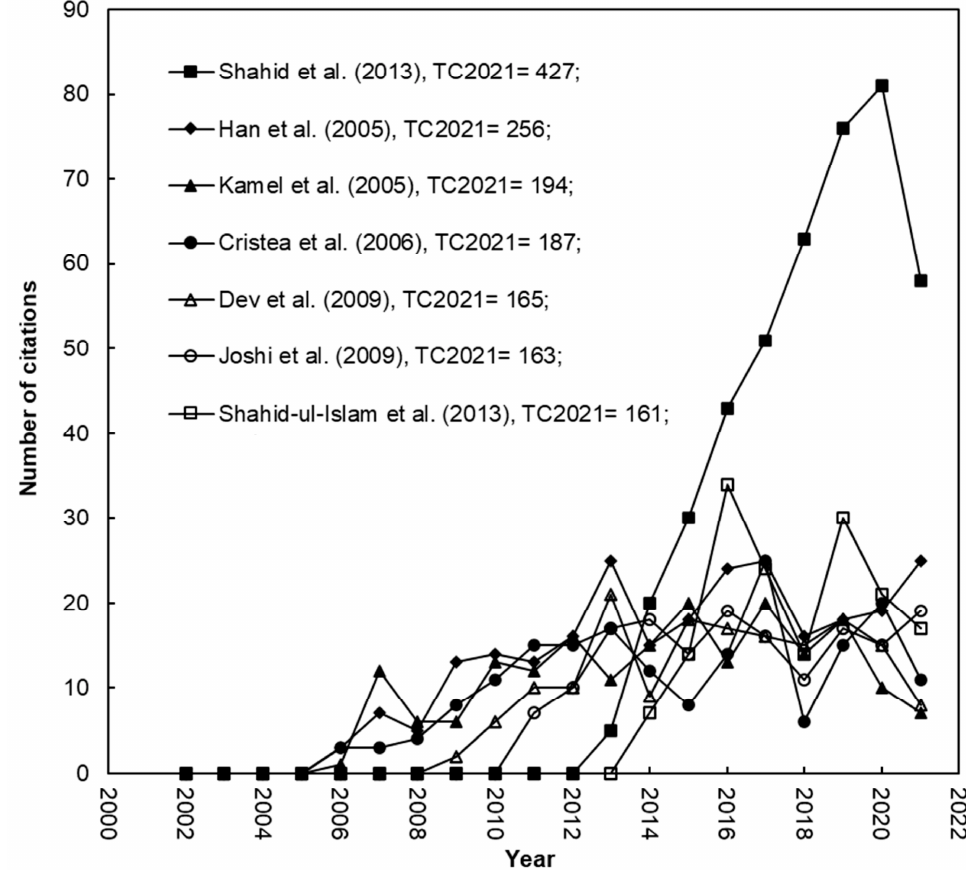
Figure 4. The citation life of the top seven most frequently cited articles with search keywords